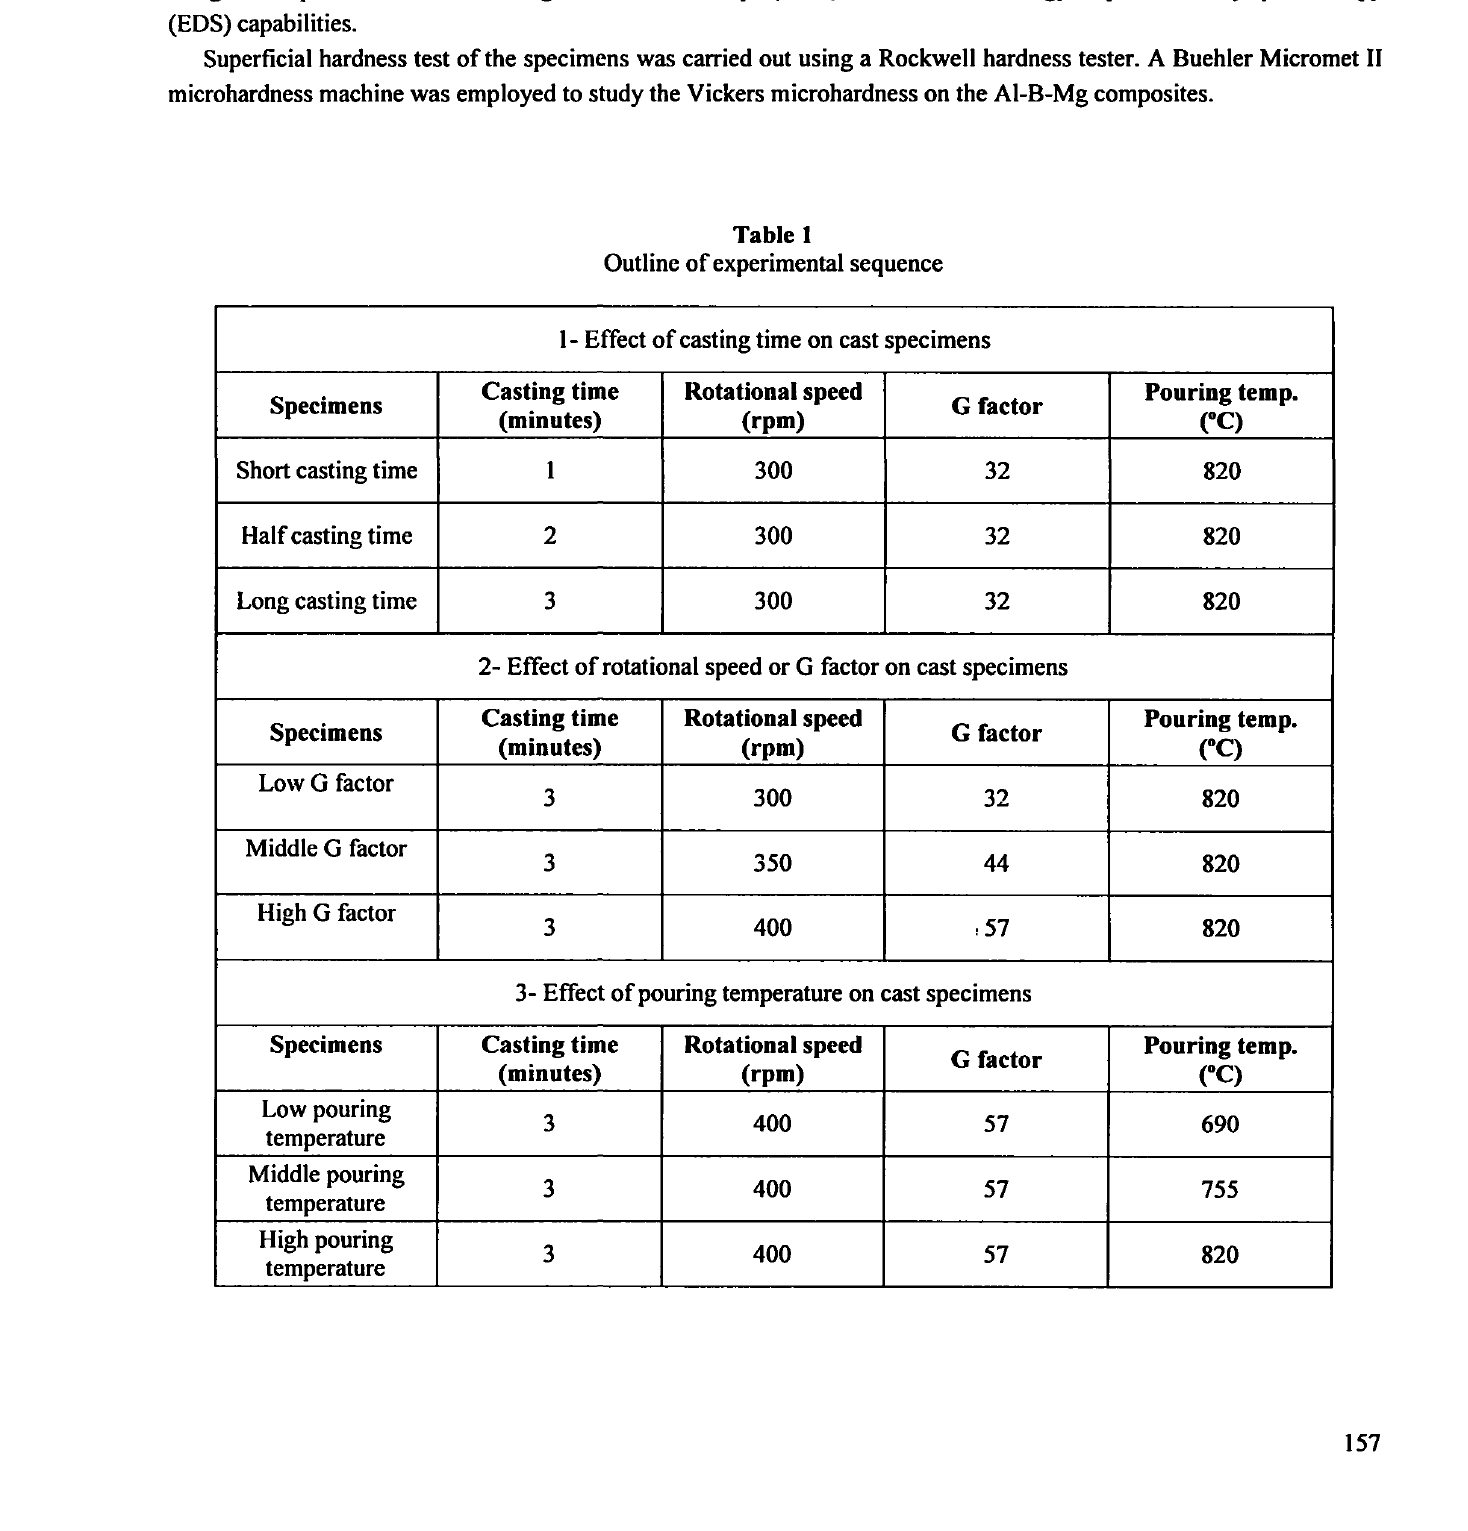
Outline of experimental sequence 1- Effect of casting time on cast